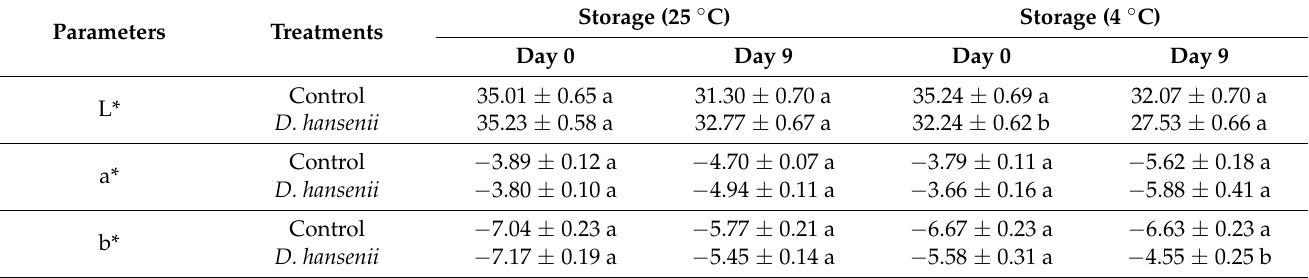
Table 2. Color parameters in blueberries treated with D. hansenii during storage at 25 and 4 ◦ C.